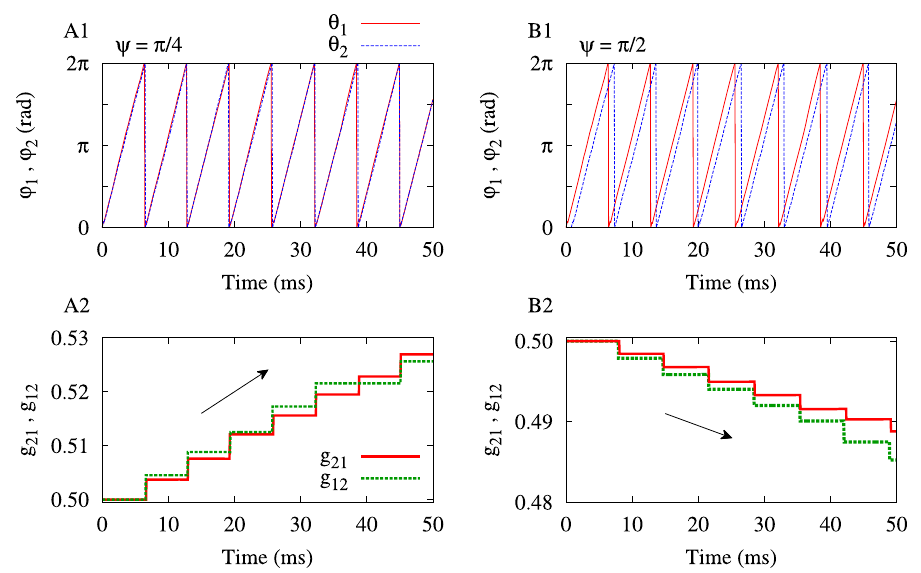
Fig 3. Activity-dependent learning in the two-neuron motif by STDP. ( A1,A2 ) Activity of the neurons in terms of the phase of oscillations characterized with strong phase synchronization ( χ � 0), when delay is ψ = π /4 (A1), and the corresponding LTP of the synapses (A2). ( B1,B2 ) Activity of the neurons in terms of the phase of oscillations associated with a loosely synchronized state (i.e. small non-zero χ ), when delay is ψ = π /2 (B1), and the corresponding LTD of the synapses (B2).